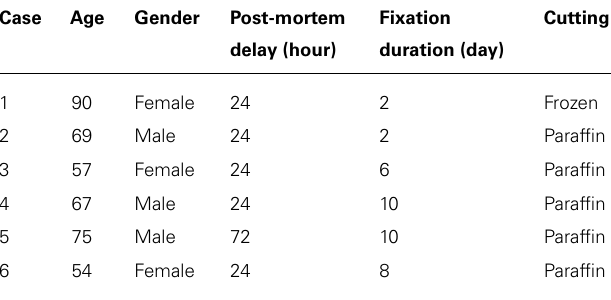
Table 2 | Human post-mortem cases used in the